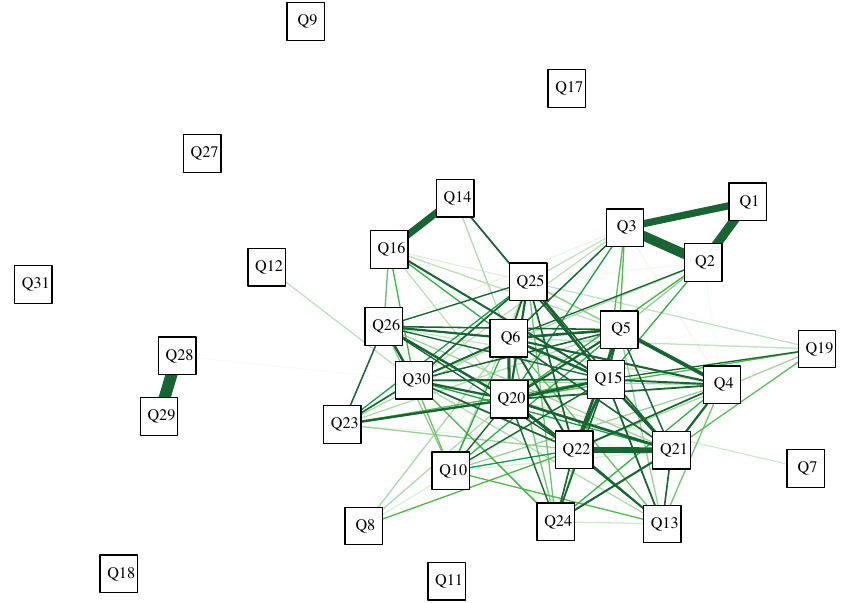
FIG. 2. Correlation matrix. Solid (green) lines represent positive correlations; dashed (red) lines negative correlations. Thicker lines represent larger